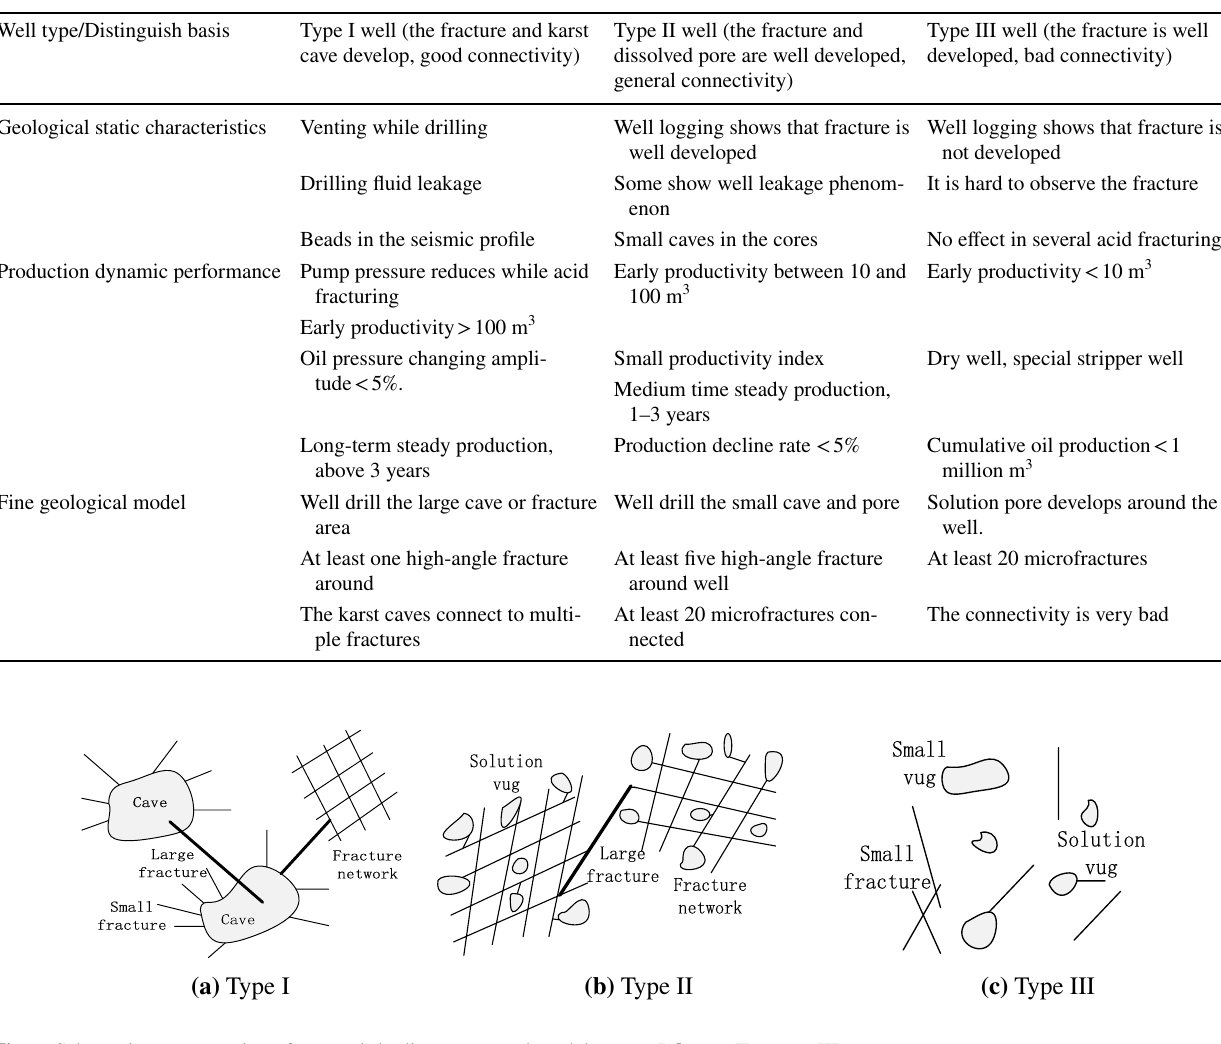
Fig. 1 Schematic representation of reservoir bodies conceptual model: a type I; b type II; c type